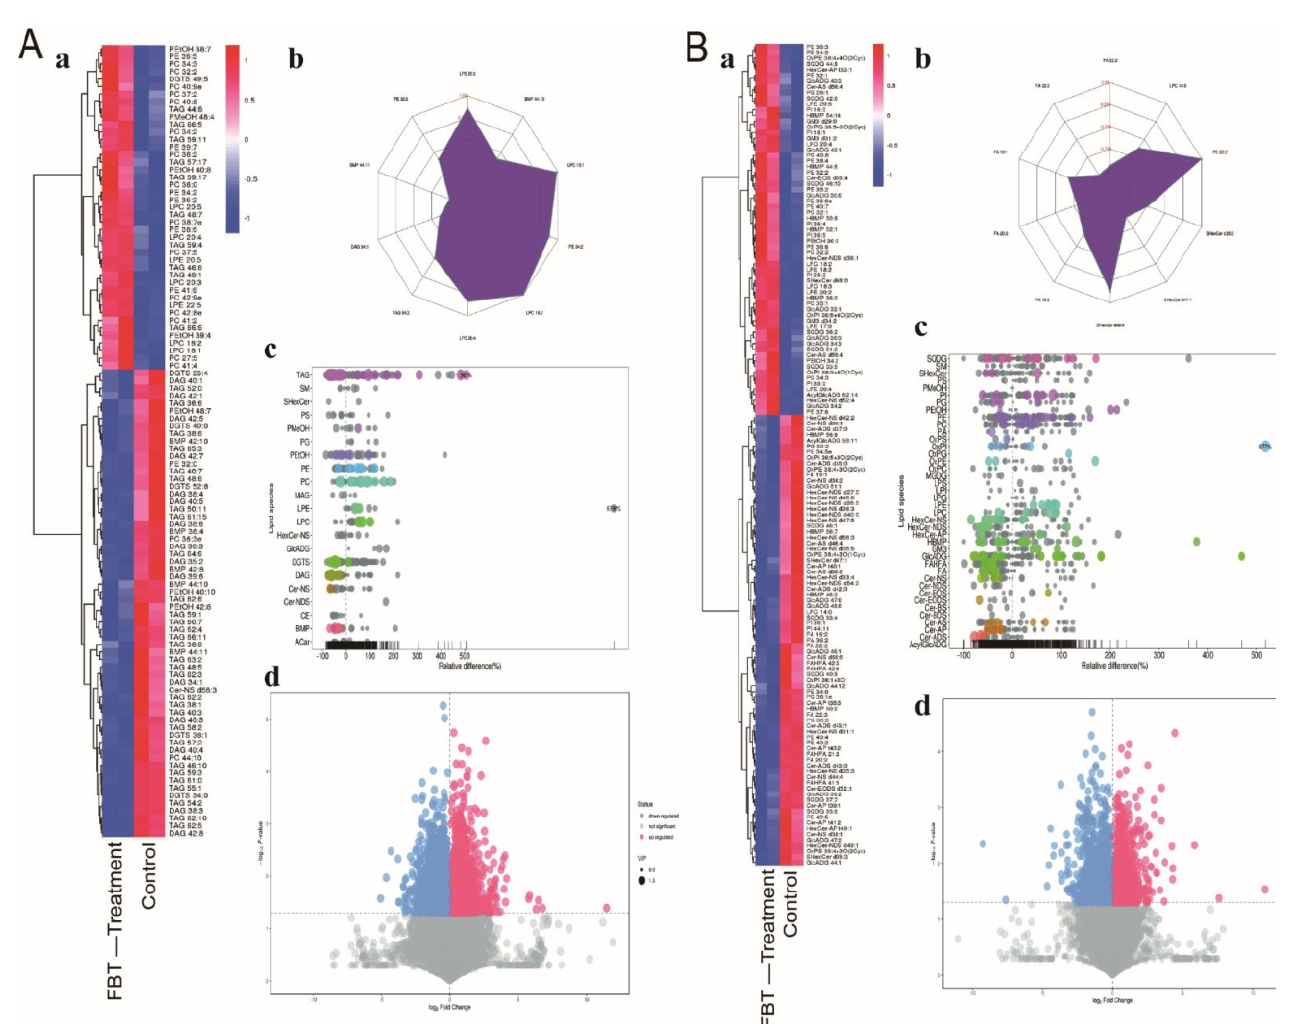
Figure 7. The ionization source of the LC-QTOFMS platform is electrospray ionization, and there are two ionization modes: ( A ) positive ion mode (POS), ( B ) negative ion mode (NEG). The combination of the two modes in the detection of the metabolome can increase the metabolite coverage rate. a: Heatmap of hierarchical clustering analysis for the group (FBT treatment vs. the control). b: Radar chart analysis for group. (FBT treatment vs. te control). c: Lipid species of bubble plot for the group (FBT treatment vs. the control). Each point in the lipid bubble diagram represents a metabolite. The size of the point represents the p -value of the Student’s t -test (taking the negative number of the logarithm base 10), and a larger point represents a smaller p -value. Grey dots represent nonsignificant differences with a p -value not less than 0.05, while colored dots represent significant differences with a p -value less than 0.05 (different colors are marked according to lipid classification). d: Volcano plot for the group (FBT treatment vs. the